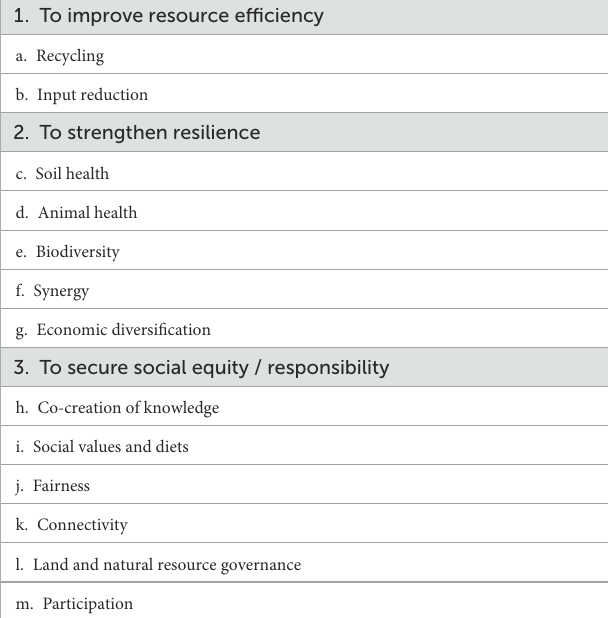
TABLE 1 Selected nutrition indicators to contribute to the big picture of TABLE 2 Comprehensive set of 13 agroecological principles as per the High cities in which the NICE project is implemented. Level Panel of Experts of the Committee on World Food Security and Nutrition’s framework of agroecology Bangladesh Kenya Rwanda